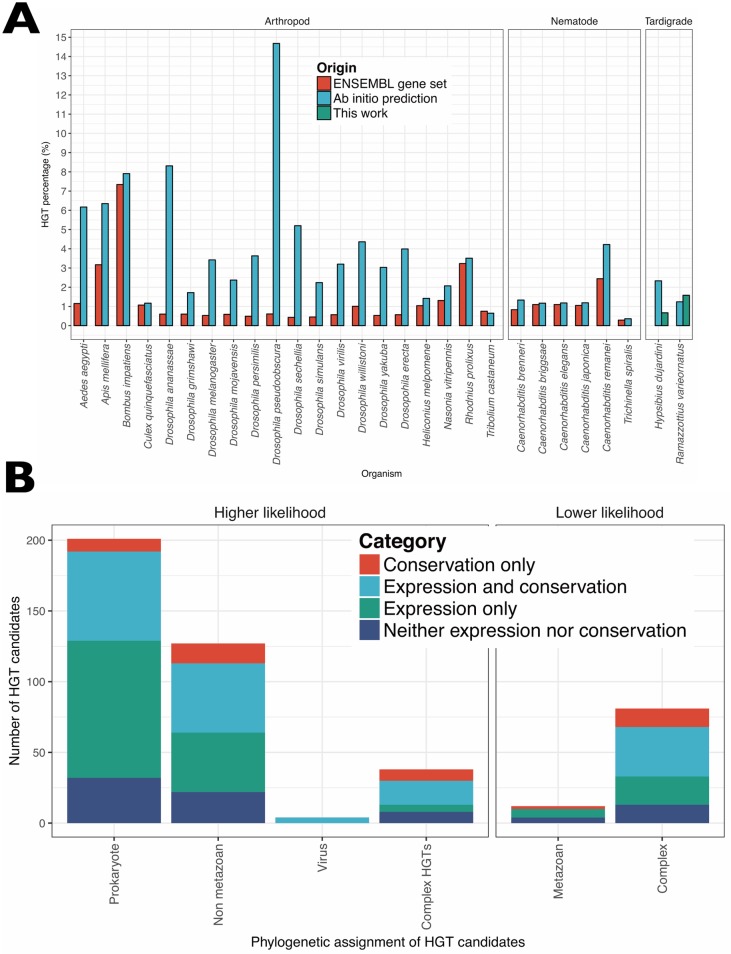
Horizontal gene transfer in H. dujardini.(A) Horizontal gene transfer ratios in various metazoa. For a set of assembled arthropod and nematode genomes, genes were repredicted ab initio with Augustus. Putative horizontal gene transfer (HGT) loci were identified using the HGT index for the longest transcript for each gene from the new and the ENSEMBL reference gene sets. In most species, the ab initio gene sets had elevated numbers of potential HGT loci compared to their ENSEMBL representations. Data available at https://github.com/abs-yy/Hypsibius_dujardini_manuscript/blob/master/data/Fig2A_HGT-content-in-metazoa.txt. (B) Classification of HGT candidates in H. dujardini. Classification of the initial HGT candidates identified in H. dujardini by their phylogenetic annotation (prokaryotic, nonmetazoan eukaryotic, viral, complex HGT, and likely non-HGT metazoan and complex), their support in RNA-Seq expression data, and the presence of a homologue in R. varieornatus. Data available at https://github.com/abs-yy/Hypsibius_dujardini_manuscript/blob/master/data/Fig2B_HGT_content_in_Hdujardini.csv.